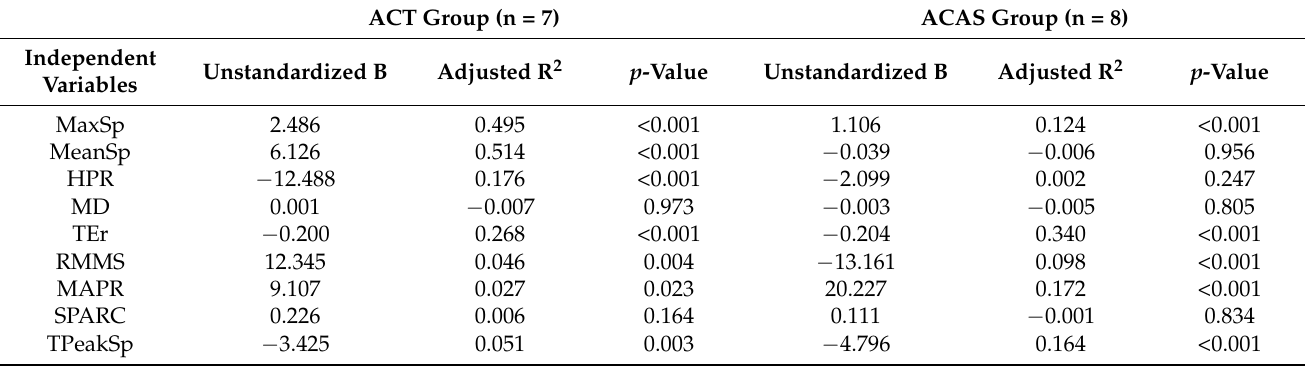
Table 5. Comparison of simple linear regression analysis of independent kinematic features for FMA-prox in the ACT and ACAS groups.